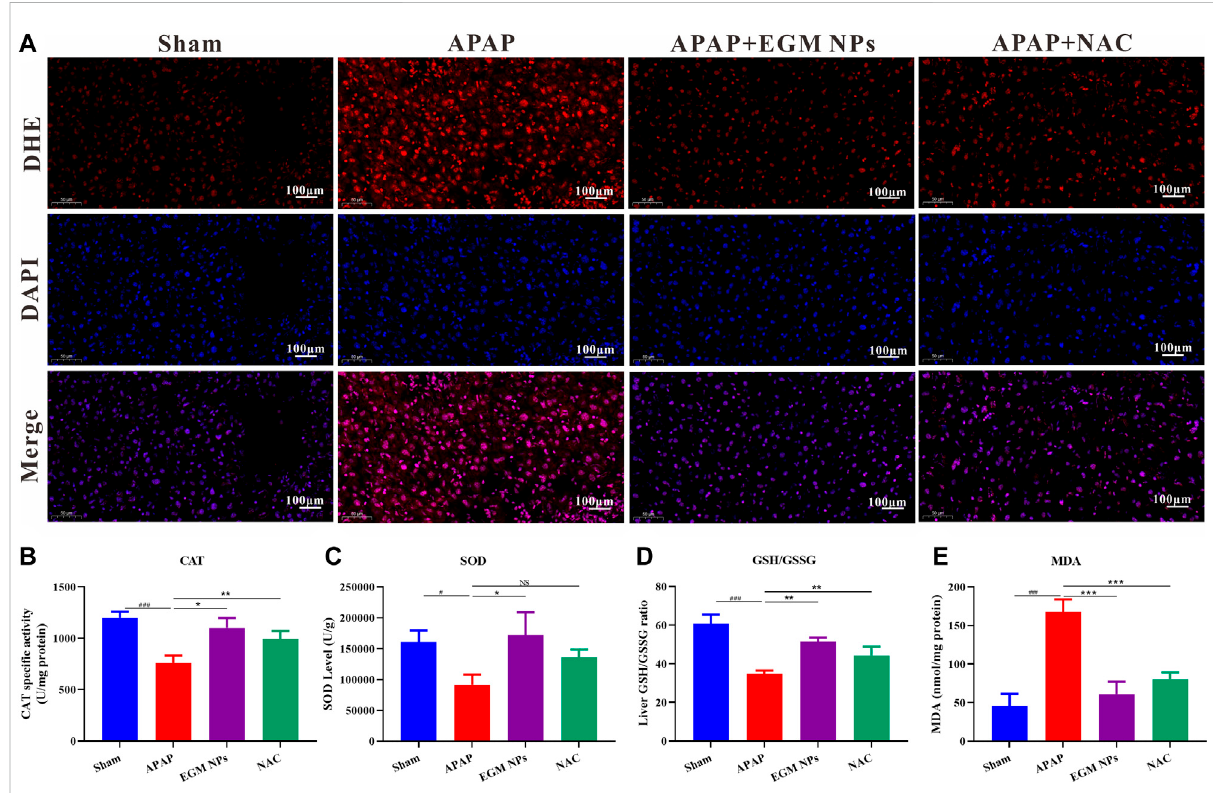
FIGURE 4 EGM NPs scavenge ROS to alleviate APAP-induced liver injury. (A) DHE staining (red fl uorescence), DAPI (blue fl uorescence) staining, and their mergeimagesoflivertissuesfromeachgroup. Scalebar:100 μ m. (B – E) CAT (B) ,SOD (C) ,GSH/GSSG (D) ,andMDA (E) levelsmeasuredinlivertissue homogenates from each group. Data represent means ± S.D. from three independent replicates. (* p < 0.05, ** p < 0.01, *** p < 0.001 vs. APAP group; # P < 0.5, ### P < 0.001 vs. Sham